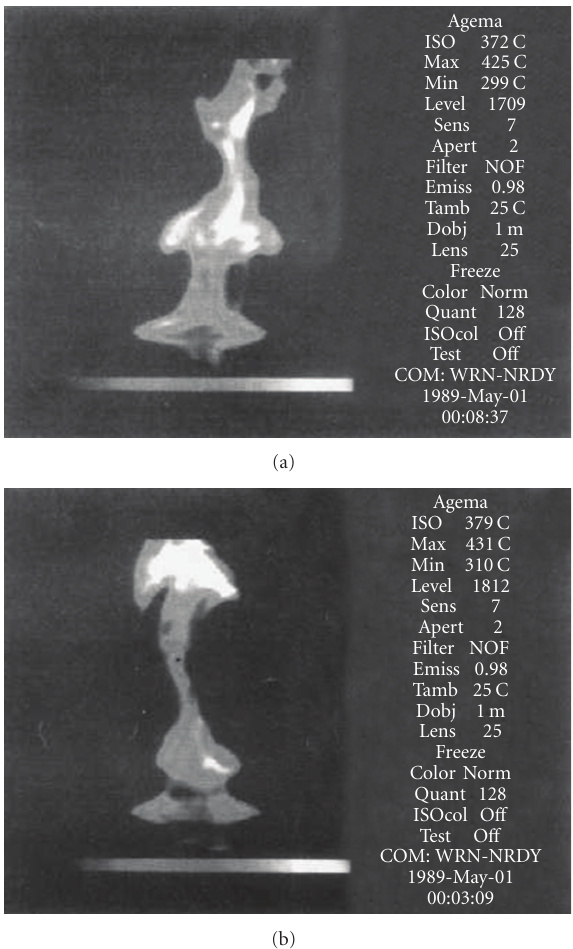
Figure 9: Thermal images of flame pulsation from